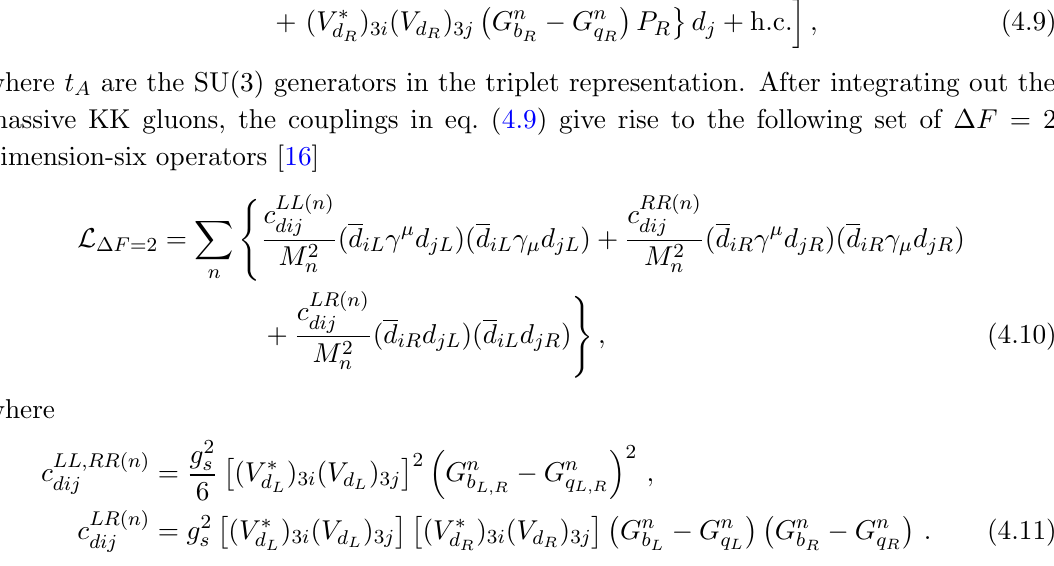
. Right panel: contour plot of (cid:27) L ; c (cid:22) ). We show as a gray band in the bottom part of the (cid:12)gure the L L > 10 (cid:0) 3 . We overlap as well the allowed region coming from (cid:1) B = 0 : L